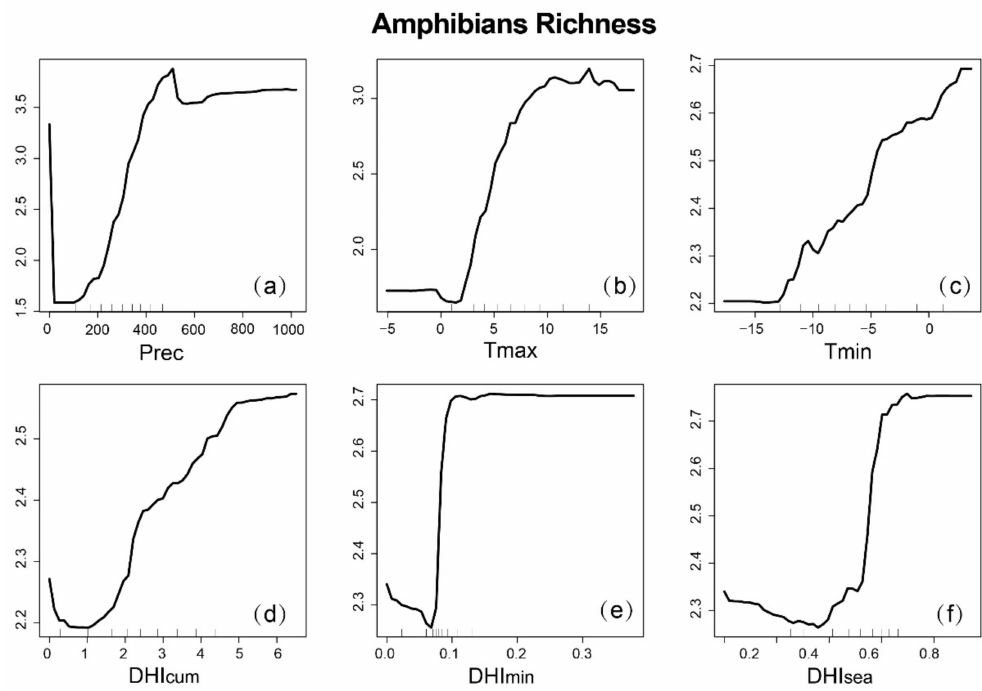
Figure 11. Partial dependence map of amphibian richness based on RF, depending on climatic variables and dynamic habitat indices (DHIs): ( a ) annual cumulative precipitation; ( b ) annual maximum temperature; ( c ) annual minimum temperature; ( d ) DHI cum ; ( e ) DHI min ; ( f ) DHI sea